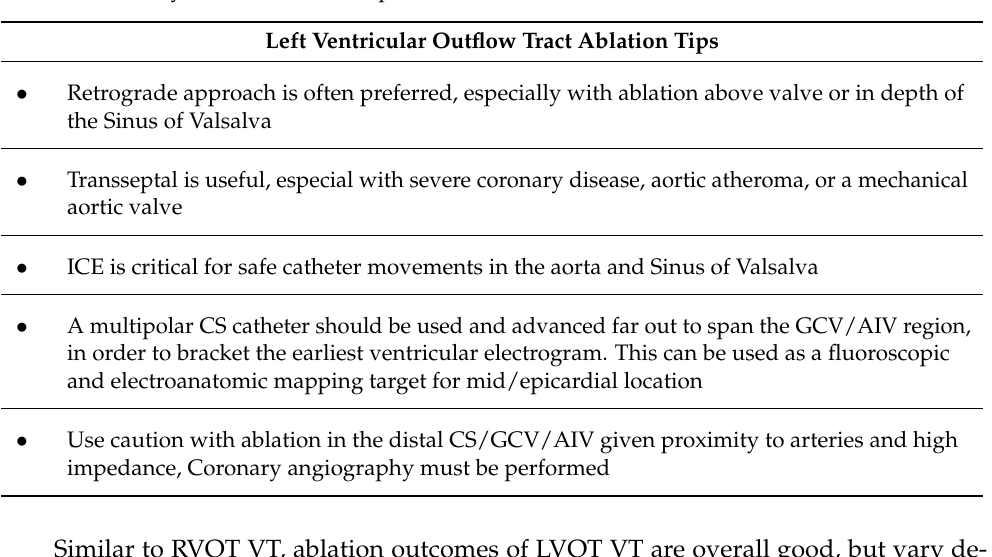
Table 2. Summary of LVOT ablation